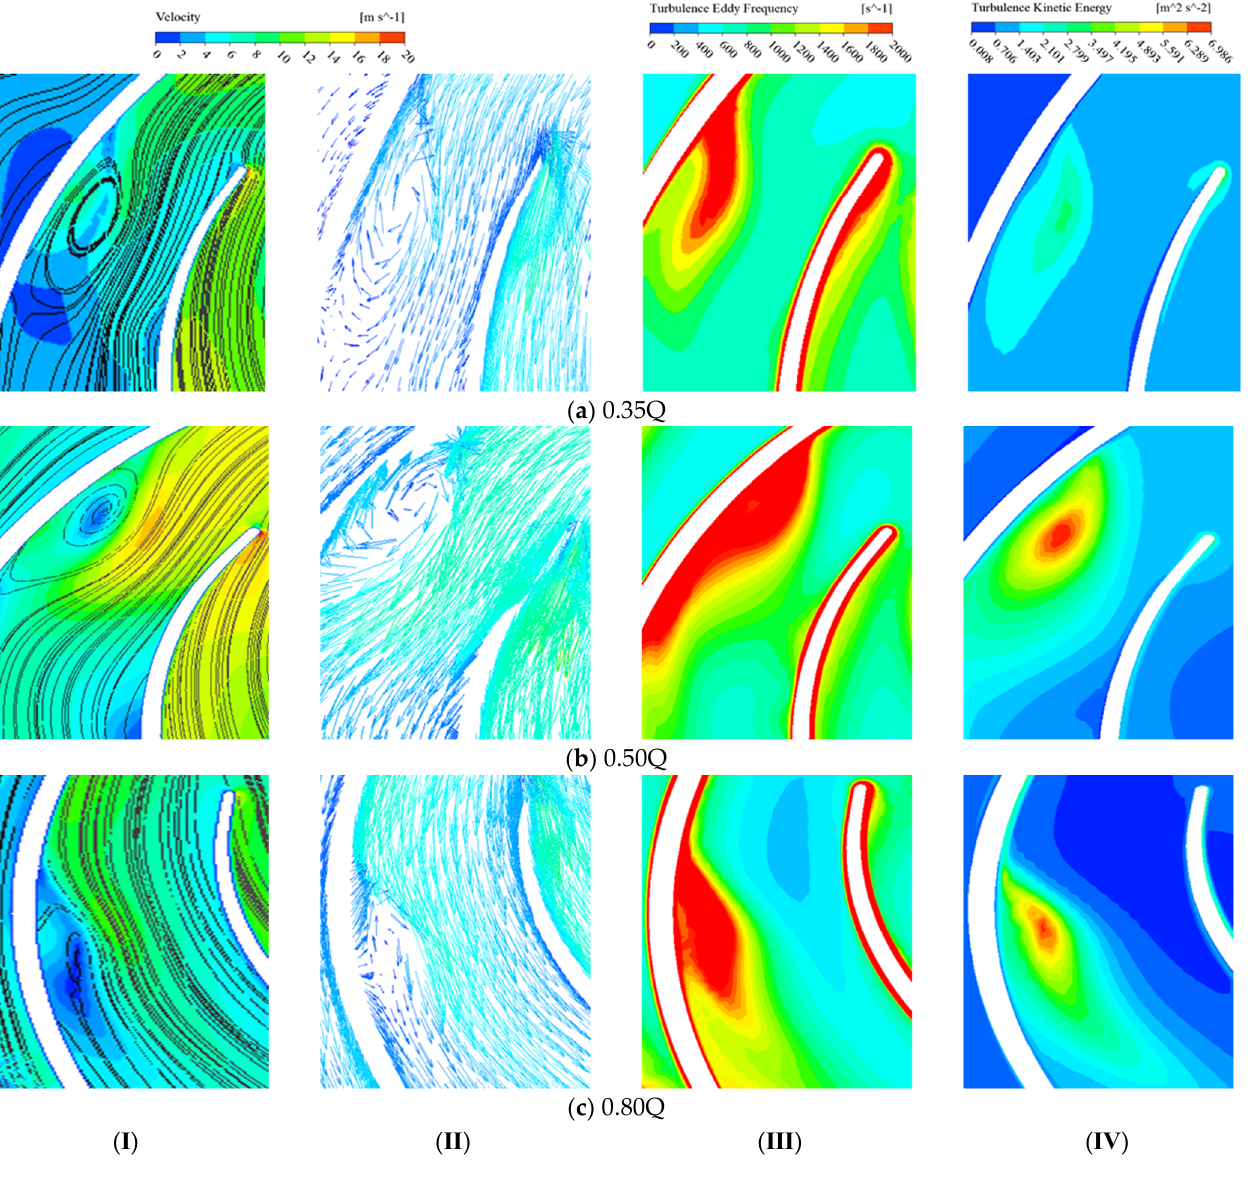
Figure 10. View of internal flow of scheme A. ( Ⅰ ) Streamline, ( Ⅱ ) Relative velocity vector, ( Ⅲ ) Turbulence vortex frequency and ( Ⅳ ) Turbulence kinetic energy.